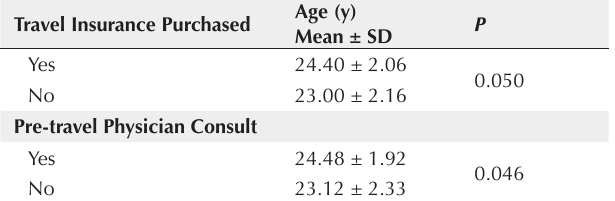
Table 2. Independent Samples T Test showing Age-Related Outcomes (n=43) Travel Insurance Purchased